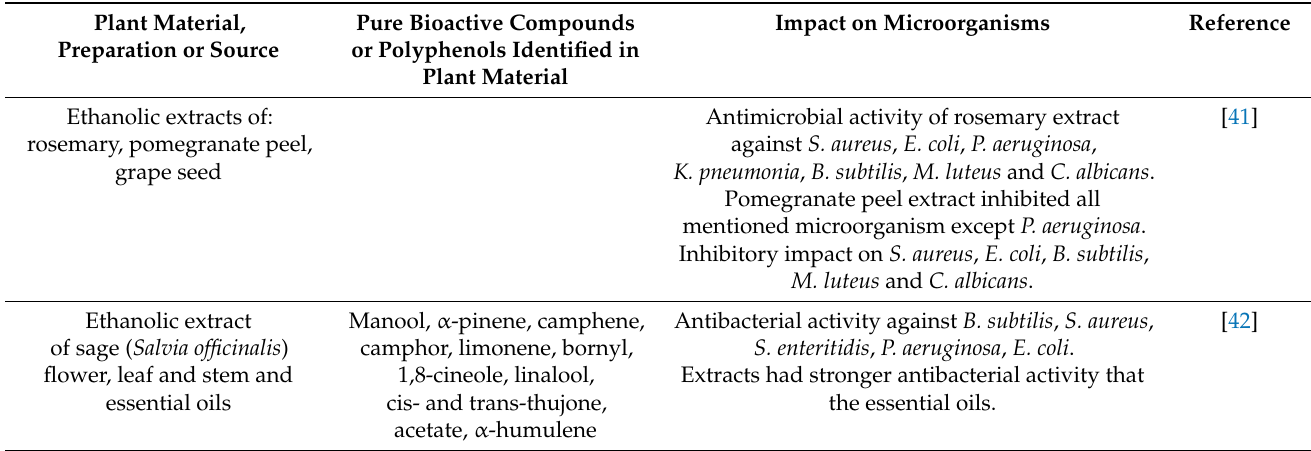
Table 1. Examples of the negative and positive impact of pure polyphenols or plant preparations (aqueous, ethanolic, methanolic or other extracts, essential oils, enriched extracts) on food-associated bacteria or the representatives of the human gastrointestinal tract